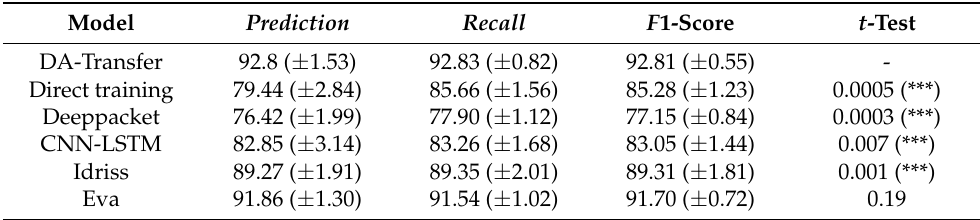
Figure 7. Macro-Average PR curves of six classification models. Table 5. Prediction, recall, F 1-score, and t -test index of the six classification methods. *** means that the statistical test has a significant difference.